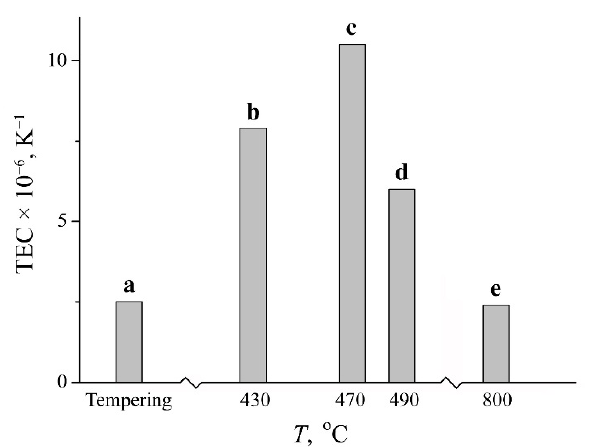
Figure 6. The thermal expansion coefficient values for the FeNi 31.1 austenite with the concentration heterogeneity. Treatment: ( a ) tempering at 1050 °C for austenite, with subsequent quenching in water; ( b – d ) (i) quenching in liquid nitrogen for the formation of α -martensite and (ii) slow heating (0.2 K/min) up to 430, 470, and 490 °C upon α → γ transformation, respectively, with subsequent fast heating up to 600 °C for 10 min upon austenitization; ( e ) (i) quenching in liquid nitrogen for the formation of α -martensite and (ii) subsequent slow heating (0.2 K/min) up to 800 °C upon α → γ transformation.